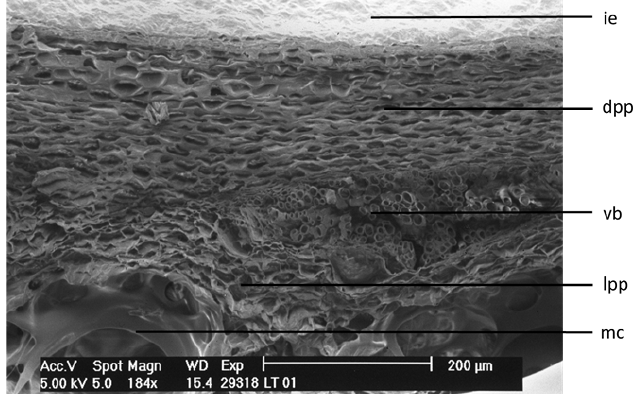
Fig. 5: SEM image of a testa cross-section from a fresh but depulped cacao seed. The mucilage caverns are oriented to the bottom; the inner epi- dermis is directed to the top of the figure. vb = vascular bundle, mc = mucilage cavern, ie = inner epidermis, dpp = densely packed paren- chyma, lpp = loosely packed parenchyma. The location of the silvery layer would be adjacent to the inner epidermis of the endotesta.